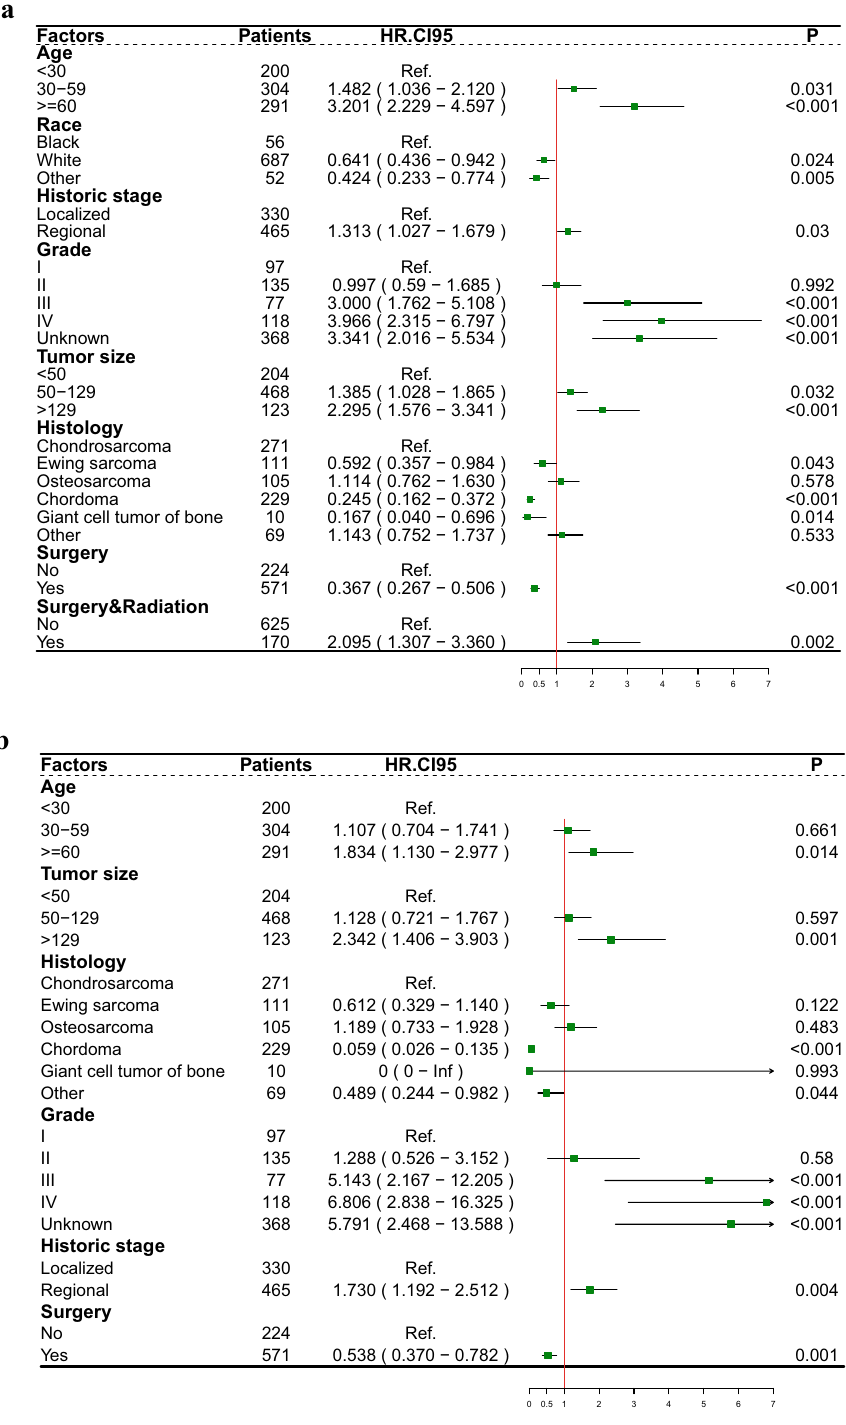
Figure 1. Forest plot depicting the effect of different prognostic factors on overall survival (OS) ( a ) and cancer- specific survival (CSS) ( b